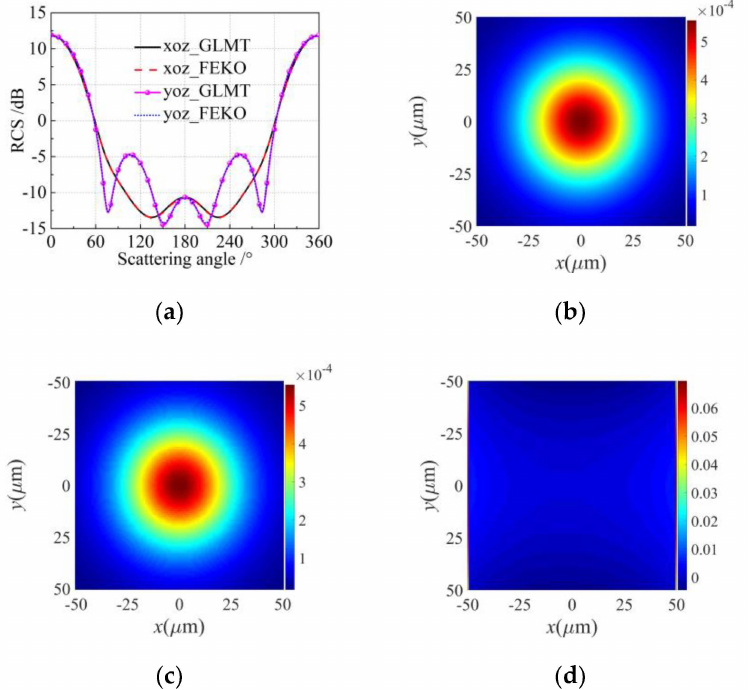
Figure 1. Comparison of the results calculated by the Mie scattering theory and FEKO: panel ( a ) is the radar cross section (RCS); panels ( b ) and ( c ) are the scattered field distributions obtained by the GLMT algorithm and FEKO simulation, respectively; the relative error between them is shown in panel ( d